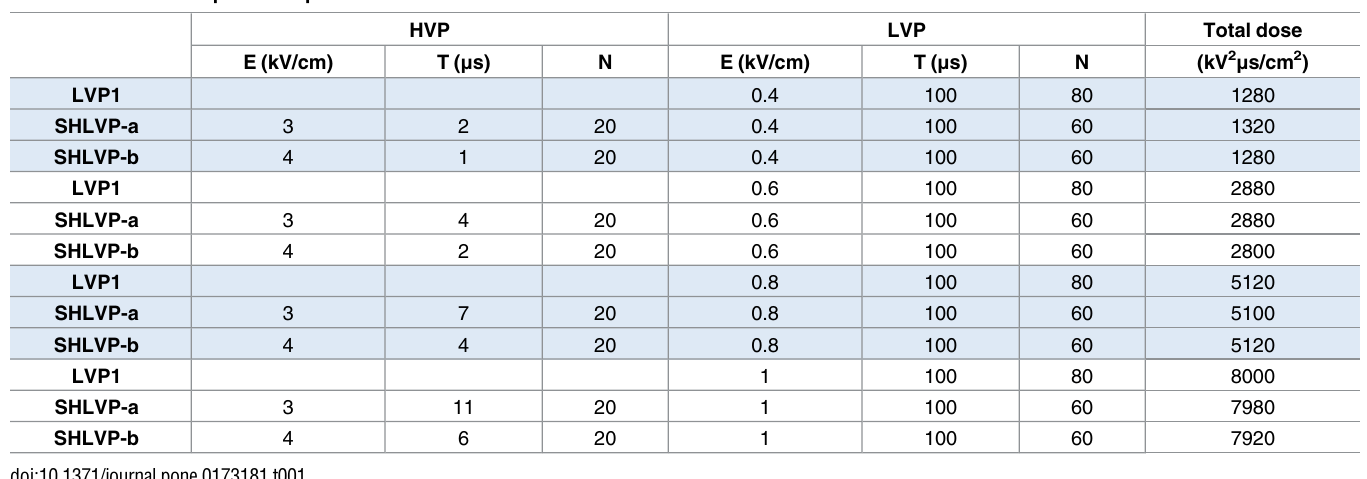
Table 1. Schemes for pulsation protocols with the similar dose.